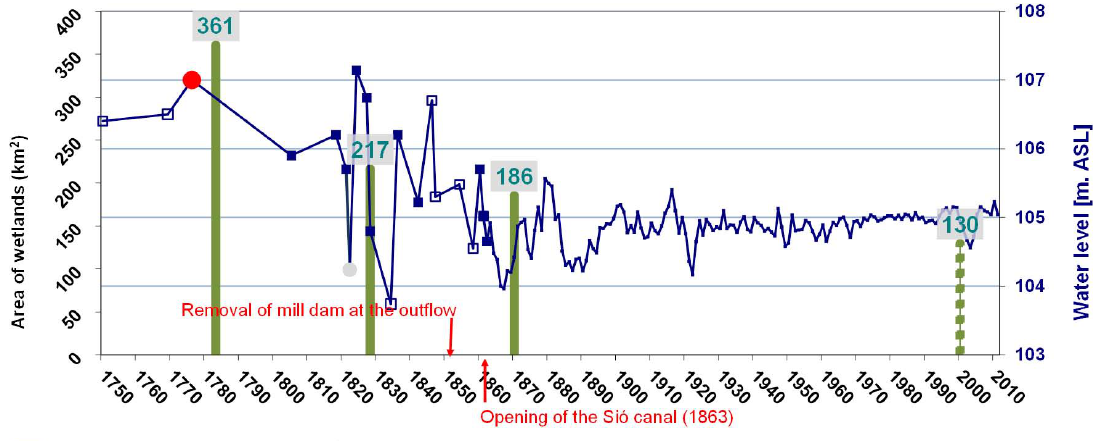
Fig. 4. Reconstructed, estimated and measured water levels of Lake Balaton and changes of wetland area through time on the Lake Balaton